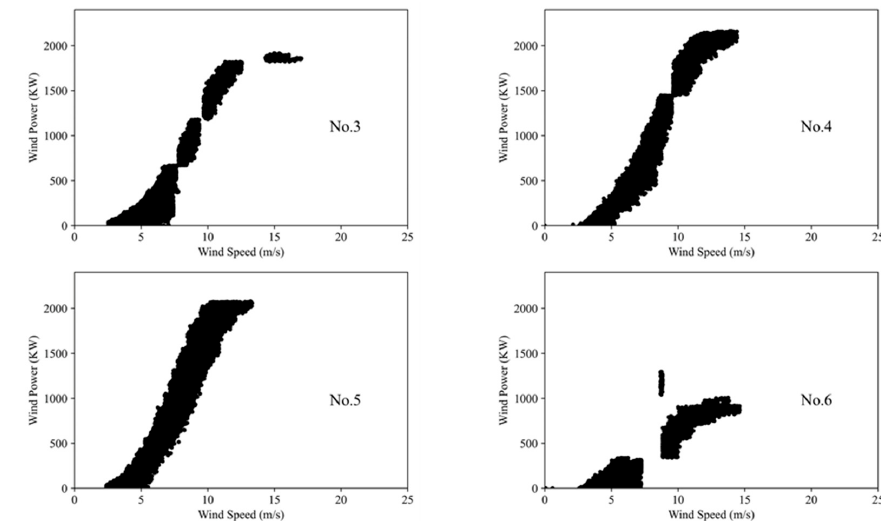
Figure 7. Abnormal data filtering result via FA.